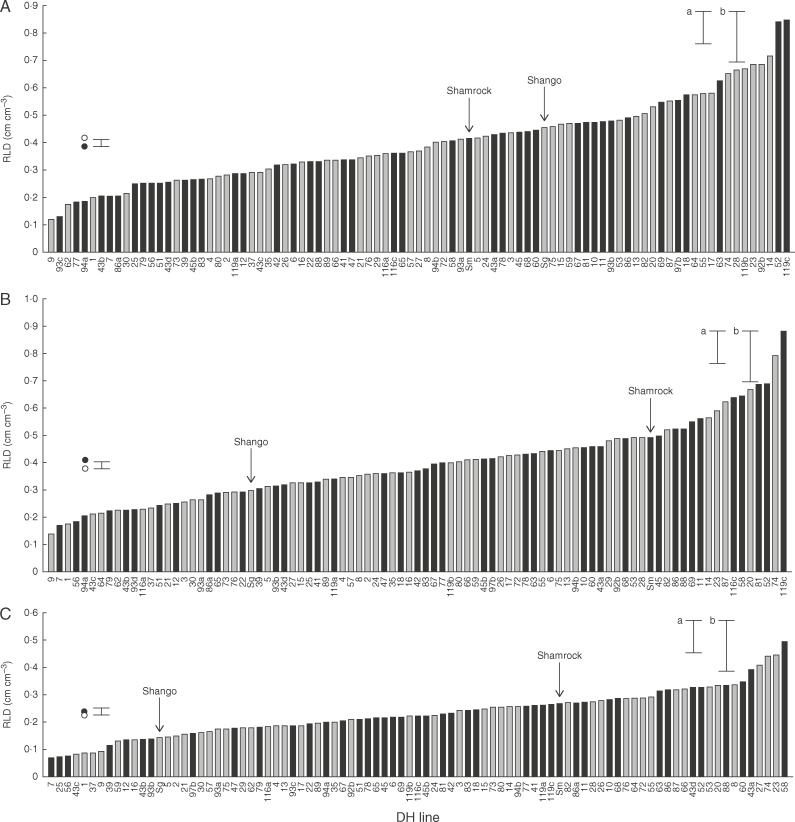
Root length densities (RLDs) of a Shamrock × Shango doubled haploid (DH) population in field-grown plots at anthesis. (A) 50–60cm depth; (B) 60–70cm depth; (C) 70–80cm depth. Black bars denote non-glaucous lines and grey bars glaucous lines. Shamrock and Shango means are labelled. Circles represent means of glaucous (open circles) and non-glaucous (filled circles) lines. The error bar is 1 SED for line means and glaucous and non-glaucous average; (a) SED for Shamrock × Shango, n=12; and (b) SED for DH line, n=6.